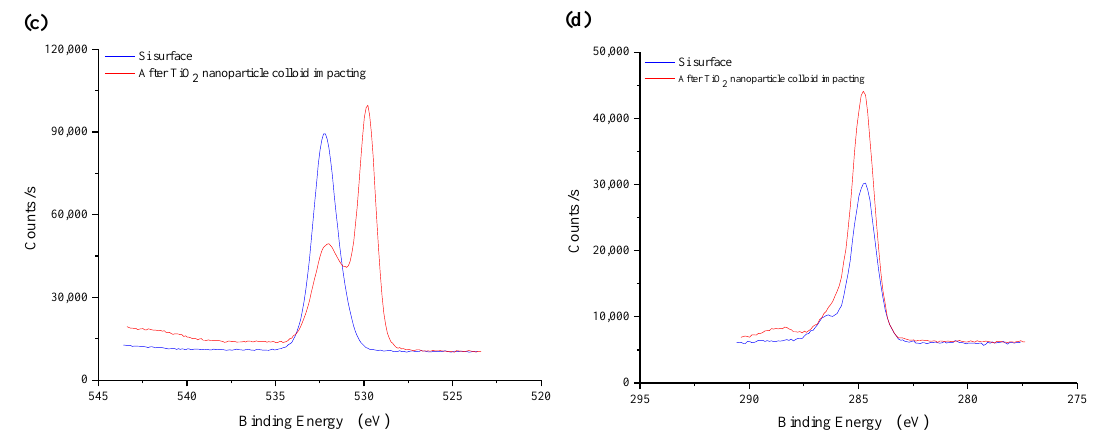
Figure 14. The fine spectrum of XPS on the silicon surface before and after TiO 2 nanoparticle colloid jet impacting. ( a ) Si 2p scans; ( b ) Ti 2p scans; ( c ) O 1s scans; ( d ) C 1s scans.